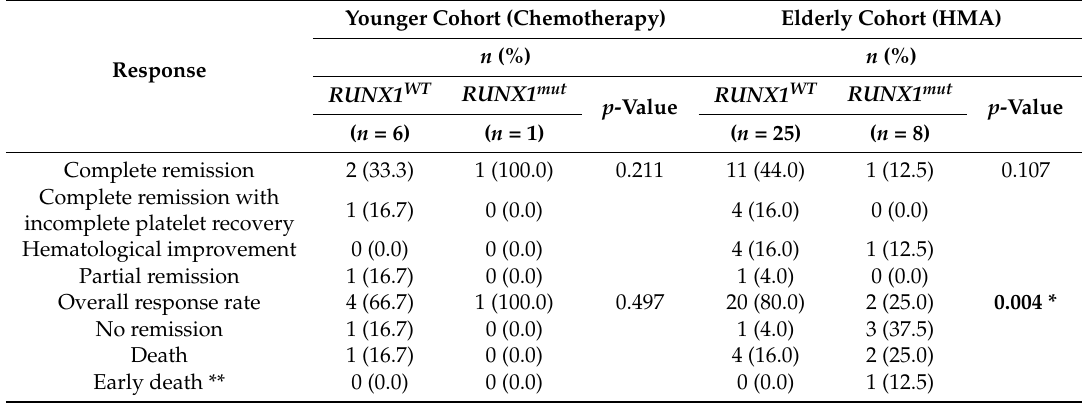
Table 3. Clinical outcomes of patients with prior MDS or MPD according to age, treatment, and RUNX1 mutation